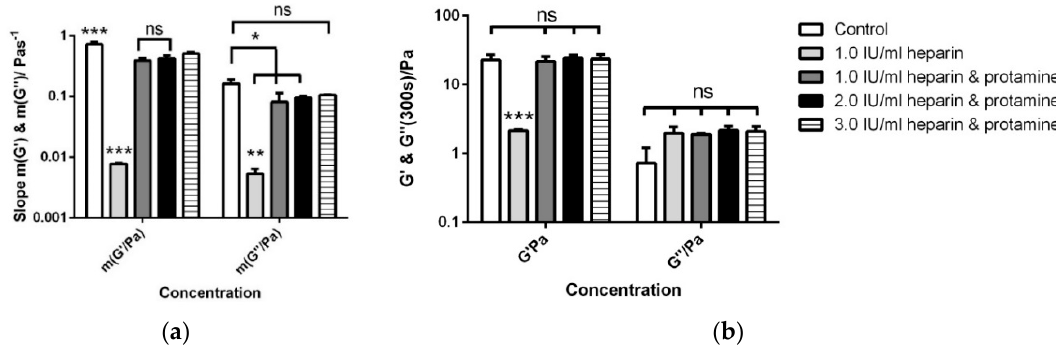
Figure A8. The oscillatory rheometer measurements of heparin-antagonising with protamine in citrated blood activated with Thromborel ( n = 5). The asterics above the bars indicate that this particular bar is significantly different from all others. ( a ) The mean linear slopes of elastic (G ′ ) and viscous (G ″ ) shear moduli (±SD) of citrated blood with heparin and protamine are still significantly less steep than the control sample without heparin, but much steeper than the heparinised sample without protamine; ( b ) The means of elastic (G ′ ) and viscous (G ″ ) shear moduli at 300 s (±SD) of the protamine-antagonised heparin samples are not significantly different from the non-heparinised control, indicating a similar clot firmness in those samples. * p < 0.05, ** p < 0.01, *** p < 0.001, ns-non significant.